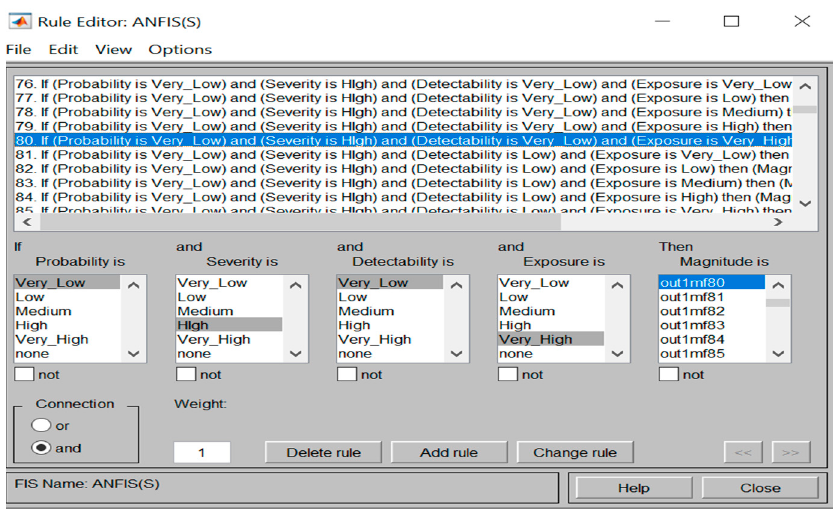
Figure 9. Rule viewer created for the training datasets.